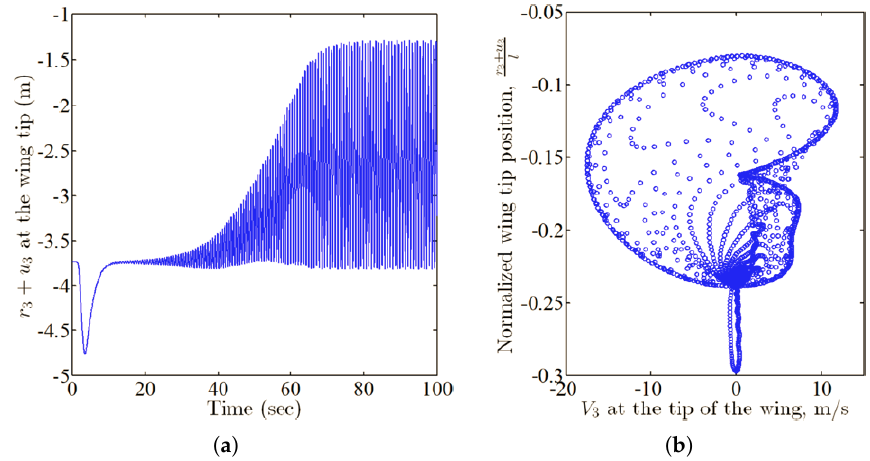
Figure 10. Nonlinear dynamic response of a wing due to time dependent engine thrust for different engine placements. Green areas show the safe zone, where oscillations due to large excitation die out, orange areas show the engine locations leading to limit cycle oscillations above flutter speed, and red zones present the unsafe engine locations.